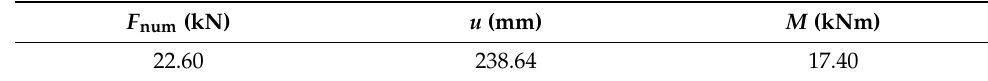
Figure 16. Experiment A: Load – deformation curves of quasi-static numerical modeling for individual specimens made from a combination of bolts and dowels. Table 8. Results of numerical modeling, Experiment A.